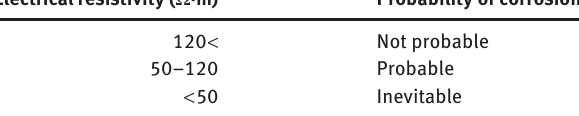
Table 5 Relation between electrical resistivity and probability of corrosion [23].